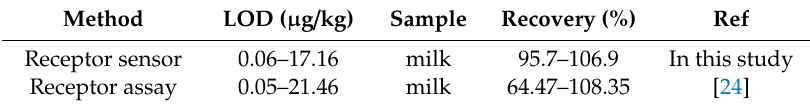
Table 1. Comparison of the characteristics of our receptor-sensor with ELISA